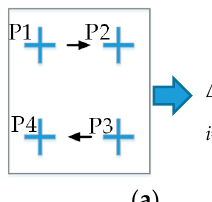
Figure 2. Motion of the cross-hair marks in the calibration process, in which, from P1 to P4, are reference points; Δ xi, Δ yi: are pixel distances between the two adjacent points along the x axis and the y axis, respectively. (a) and (b) show the travel of the cross-hair mark along x and y axis directions, respectively.